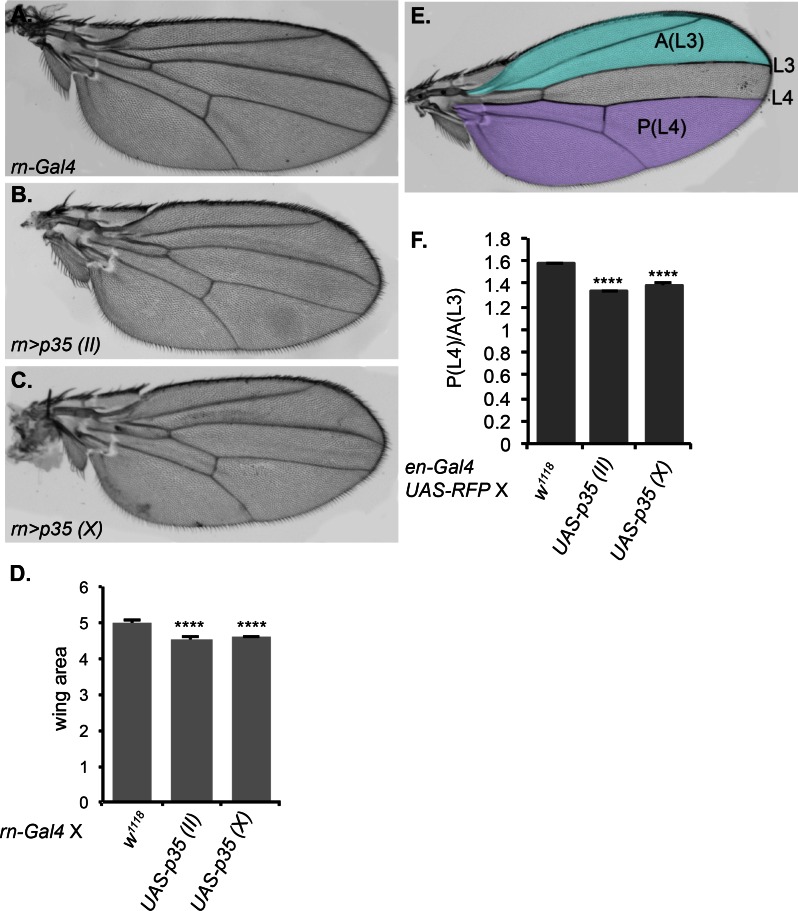
Inhibition of caspase activity reduces wing size.(A–C) Representative wings from progeny of rn-Gal4 crossed to (A) control w1118, (B) UAS-p35 on chromosome II, or (C) UAS-p35 on the X chromosome. (D) Quantification of wing area in arbitrary units. (E) Schematic showing the regions used for area measurement in wings with or without p35 expressed under en-Gal4. In the anterior compartment, we measured the area anterior to L3 vein, which is highlighted in blue and marked as A(L3). In posterior compartment, we measured the area posterior to L4, which is highlighted in purple and marked as P(L4). (F) Quantification of the ratio between P(L4) and A(L3) in wings from progeny of en-Gal4 crossed to w1118, UAS-p35 on the second chromosome, and UAS-p35 on the X chromosome. Error bars show standard error of the mean, and **** indicates p<0.0001.